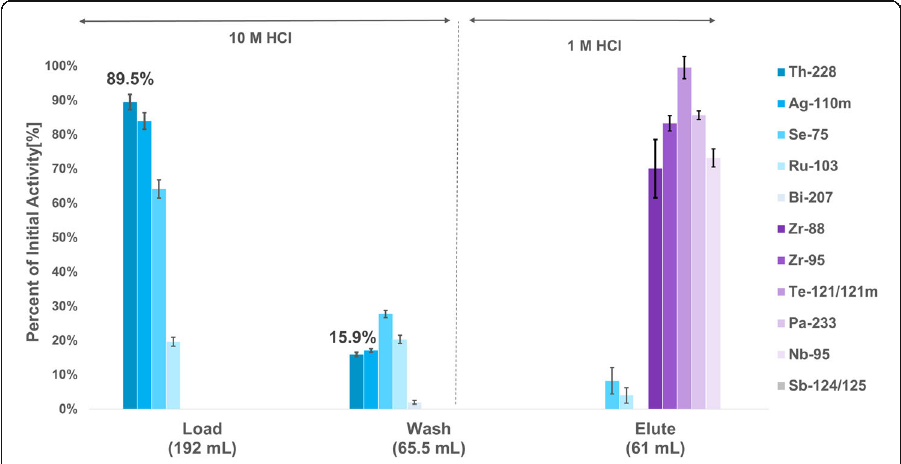
Fig. 4 Separation of 228 Th from other isotopes on a 1 × 8 Dowex anion exchange column (10